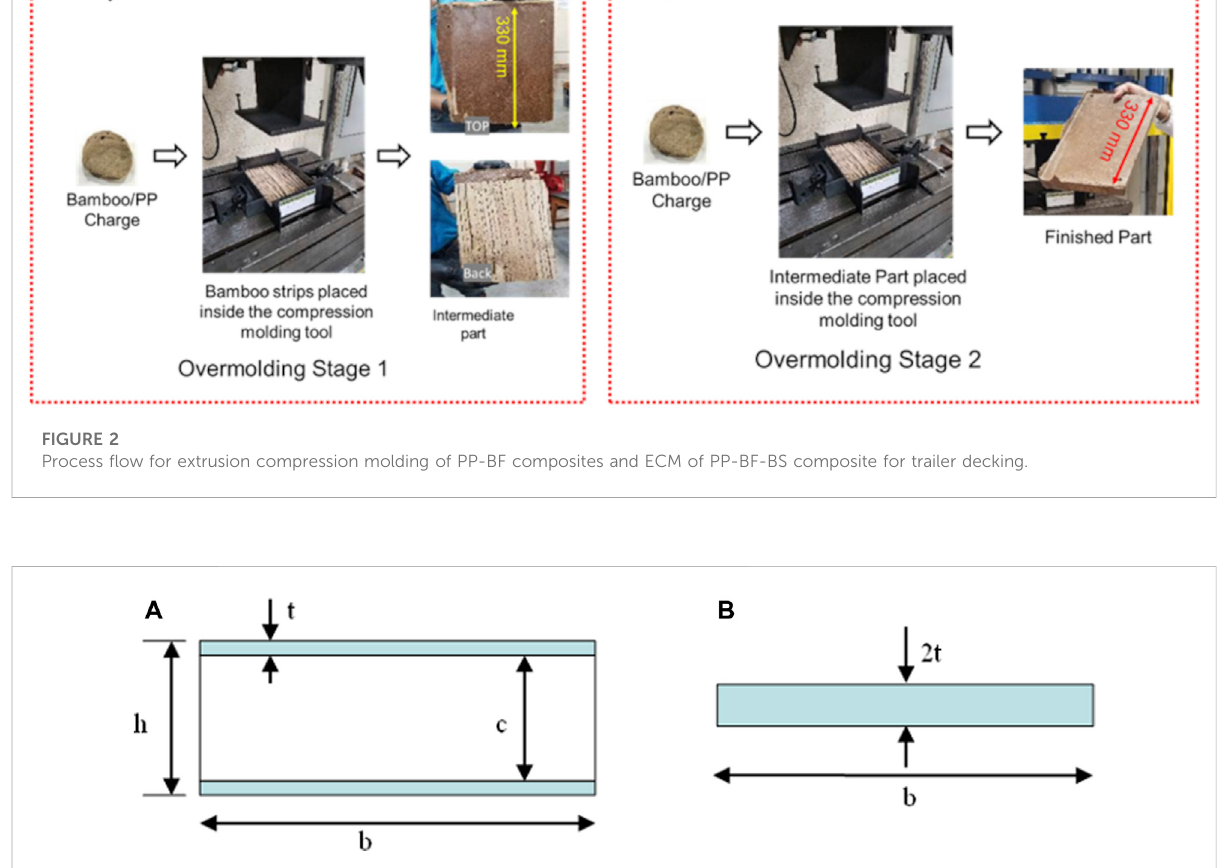
stiffness for the monocoque construction shown in Figure 3B is: